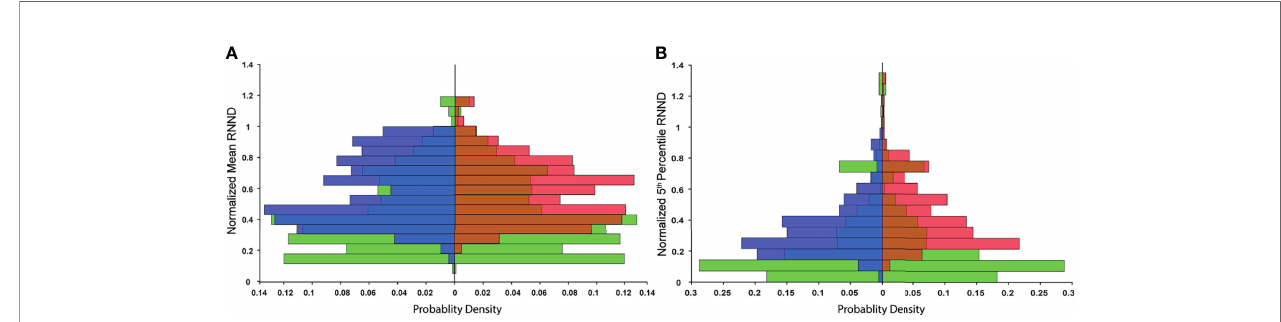
FIGURE 4 | Probability distribution of RNND values over all cases: to remove the effect of biological variability, RNND values for each case are fi rst normalized to the maximum post-injection RNND of the same case. (A) shows three probability distributions of normalized mean RNND values for pre-injection (green), post-simulation (blue), and post-injection (red), and (B) shows the probability distribution of normalized 5th percentile